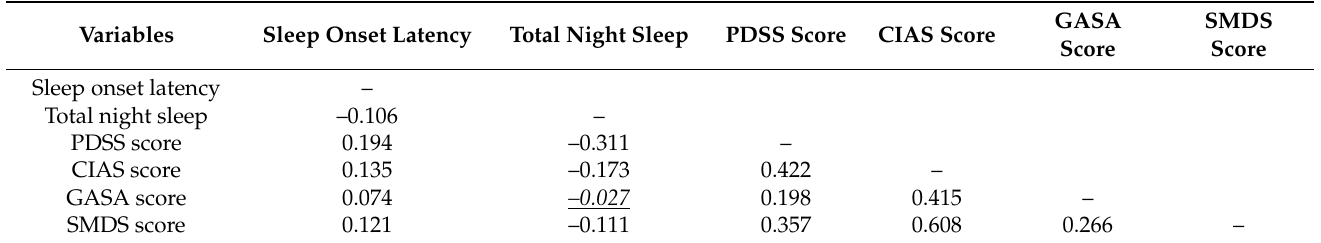
Table 9. Correlation matrix of studied